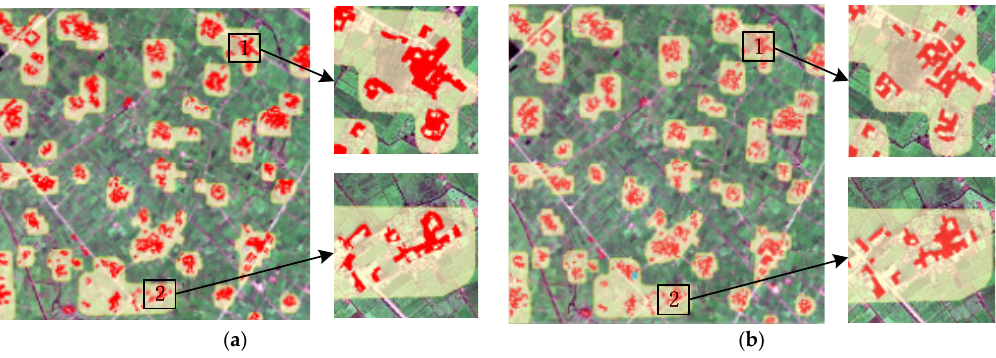
Figure 8. Building results of two compared models: ( a ) “SR+gCRF”; and ( b ) gCRF_MBI.